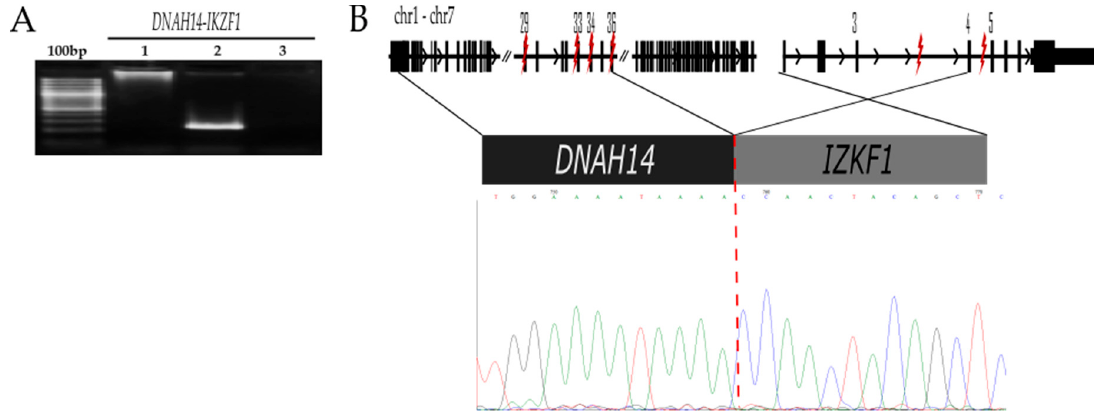
Figure 2. Detection of the DNAH14-IKZF1 fusion sequence A. Genomic PCR products were obtained from original genomic DNA samples. We used primer sets at the intronic breakpoint between exon 36 of DNAH14 with exon 4 of IKZF1 (Table S1). ( A ) 100 bp marker, PCR of DNAH14-IKZF1 with genomic DNA of DNAH14-IKZF1 -negative sample 74MO (lane 1), genomic DNA of 179 sample (lane 2), and H 2 O as negative control (lane 3). ( B ) Schematic representation of the DNAH14-IKZF1 fusion. Exon 29, 33, and 34 of the DNAH14 gene and exon 3 and 4 of the IKZF1 gene could be fused together, synthesizing different fusion transcripts. The symbol “lightning” indicates the breakpoint region. Note: Only the intronic breakpoint between exon 36 of DNAH14 with exon 4 of IKZF1 was confirmed by cloning the sequencing of the PCR product.